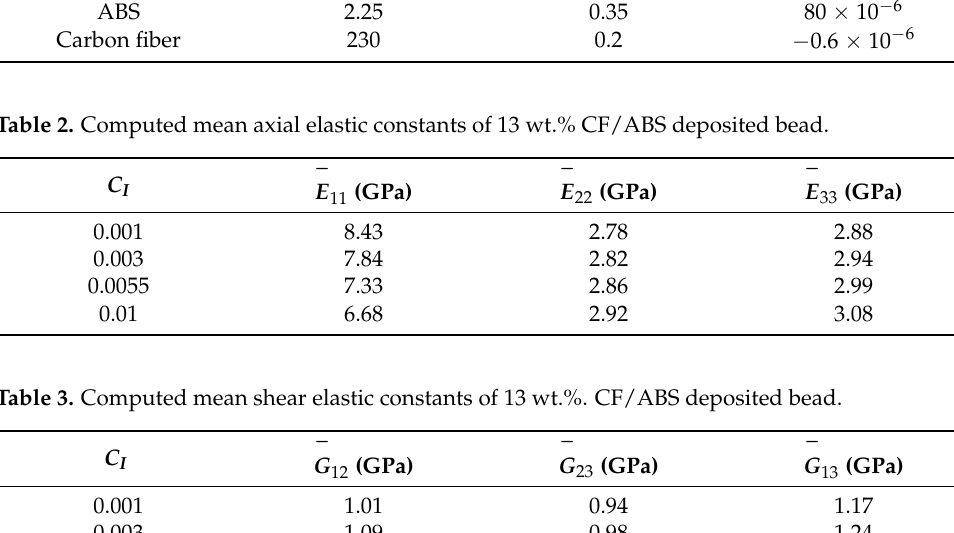
Table 1. Elastic constants of the constituents of a 13 wt.% CF/ABS [36]. Material E (GPa)